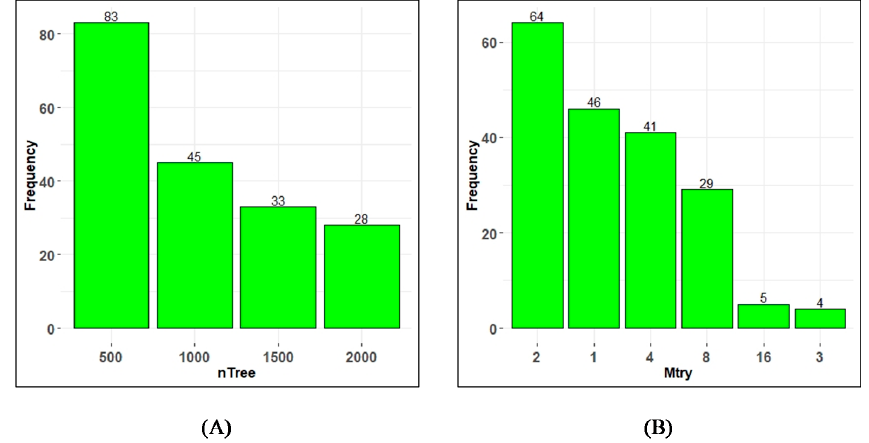
Figure A1. Occurrences of the number of tree (nTree) corresponding to minimum out-of-bag errors ( A ) and the obtained number of variables available for splitting at each tree node, mTry ( B ).